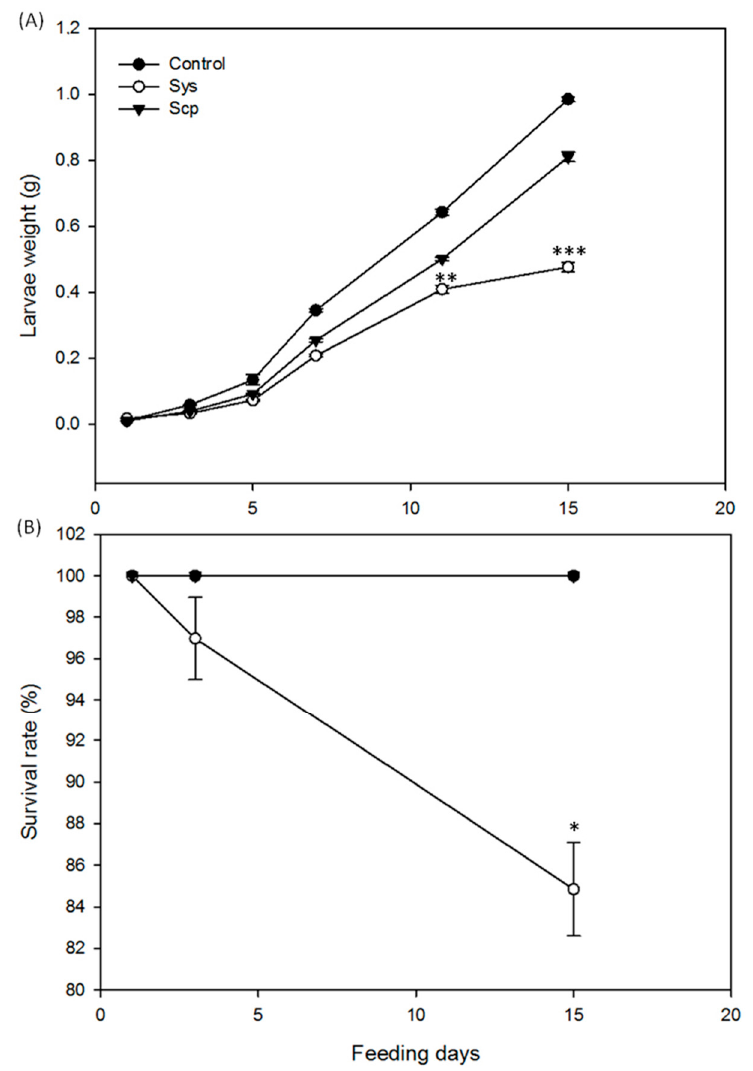
Figure 2. E ff ect on insect performance of systemin peptide supplied via hydroponics. Tomato plants were grown in hydroponic culture and supplied with 100 pM Sys or 100 pM Sys-scramble (Scp) or PBS1X. ( A ) Mean weight ( ± S.E.) of S. littoralis larvae feeding on tomato leaves. ( B ) Survival rate of experimental S. littoralis larvae. Asterisks denote statistically significant di ff erences (one-way ANOVA: * p < 0.05; ** p < 0.01; *** p < 0.001). A group of 32 larvae was used for each experimental condition and the experiment was repeated twice.